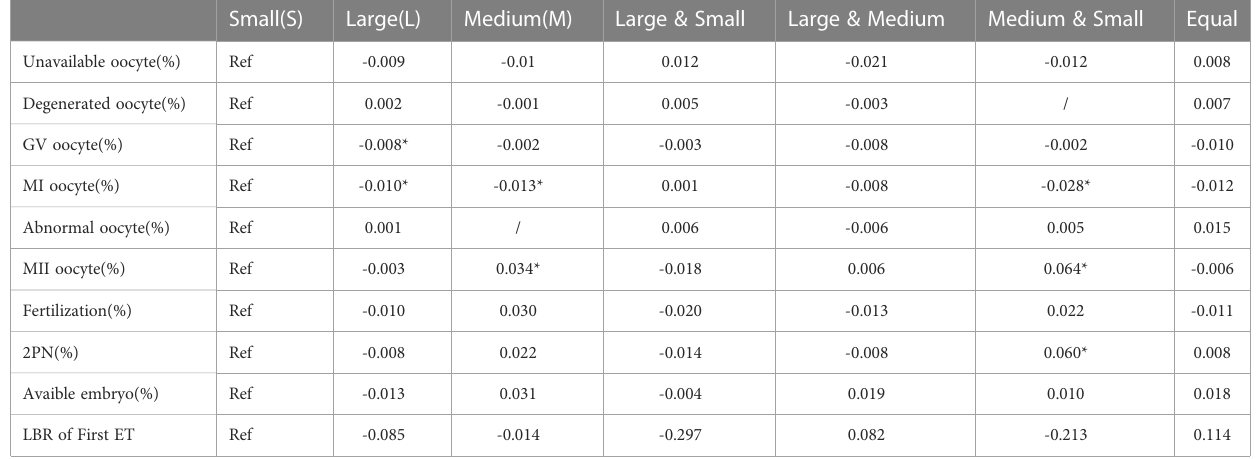
TABLE 5 GLM analysis of oocyte and embryology quality between groups in advanced-age